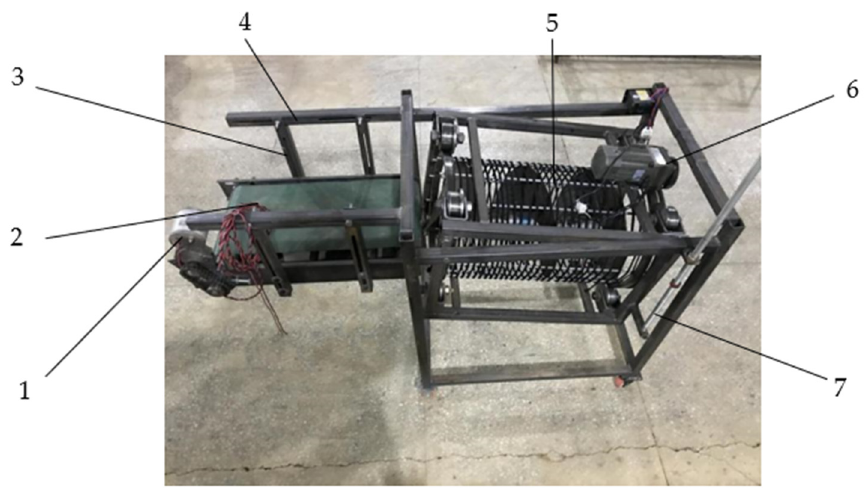
Figure 6. Test bench of lily fruit–soil separation. 1. The motor drives the front conveyor belt; 2. Front conveyor belt; 3. Height-regulating device; 4. Rack; 5. Separation device for fruit–soil; 6. The motor drives the fruit–soil separation unit; 7. Angle-adjusting device of the fruit–soil separation device.